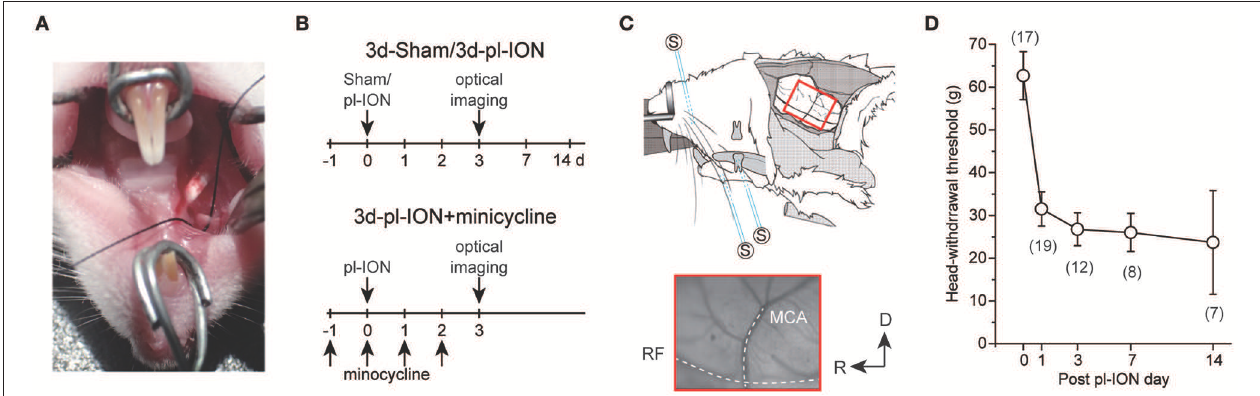
FIGURE 1 | Experimental protocols for partial ligation of the infraorbital nerve (pl-ION) and optical imaging. (A) An intraoral approach to expose ION. A black silk thread was placed under ION to show ION clearly. (B) Experimental schedules. On 0 d, pl-ION was performed, and a behavioral test was performed 1, 3, 7, and 14 d after pl-ION. Optical imaging was performed 3d after pl-ION. In the group administrated with minocycline, minocycline (30 mg/kg/d) was intraperitoneally injected from 1 d before and 2 d after pl-ION. (C) Schematic drawing of the in vivo preparation for the optical imaging and position of the stimulation electrodes [modified from ( 18) with permission]. The lower panel indicate an example of the image of the cortical surface including S1 and S2/IOR. MCA, middle cerebral artery; RF, rhinal fissure. R, rostral; D, dorsal. (D) The temporal profile of head-withdrawal threshold (HWT) before and after pl-ION. The number in the parenthesis indicates the number of